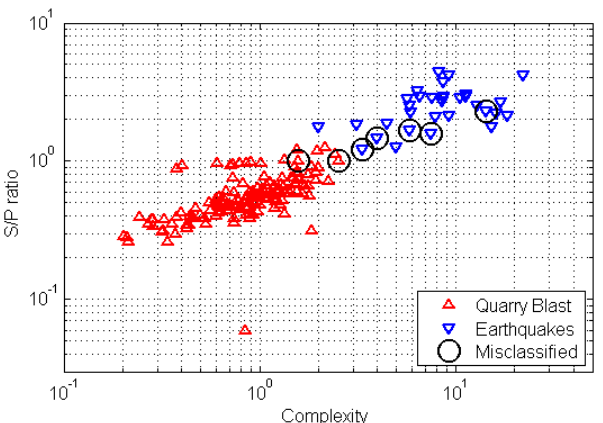
Fig. 6 The results after applying of k-means algorithm. Blue and red colors indicate earthquakes and Fig. 6. The results after applying of k -means algorithm. Blue and Fig. 5 The results after applying of Gaussian mixture model. Blue and red colors indicate earthquakes and Fig. 5. The results after applying of Gaussian mixture model. Blue red colors indicate earthquakes and quarry blasts, respectively af- quarry blasts, respectively after classification. The black circles show the misclassified events. 3 QBs and and red colors indicate earthquakes and quarry blasts, respectively ter classification. The black circles show the misclassified events. quarry blasts, respectively after classification. The black circles show the misclassified events. 5 QBs and after classification. The black circles show the misclassified events. Three QBs and six EQs are misclassified by the method. The accu- 2 EQs are misclassified by the method. The accuracy of classifier is 96.1%. Five QBs and two EQs are misclassified by the method. The accu- racy of classifier is racy of classifier is 96.1%.